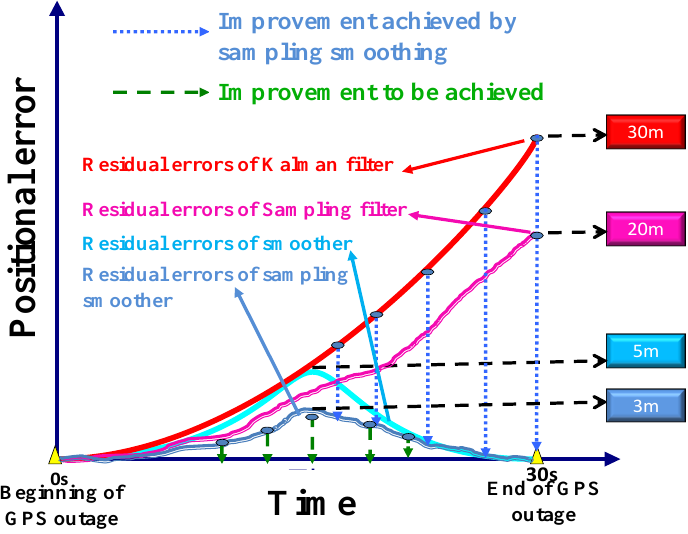
Figure 4. The error behaviors of sampling filters and smoothers during GPS